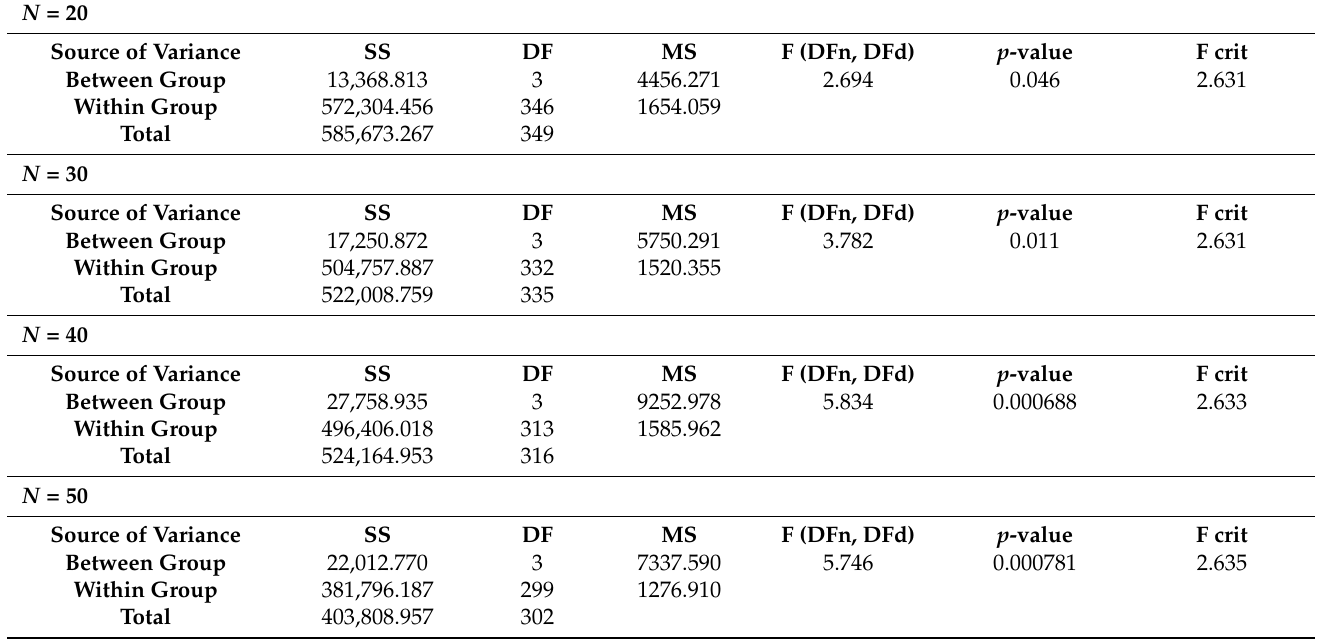
Table 2. ANOVA Test Results Based on Performance Metrics Average Time.